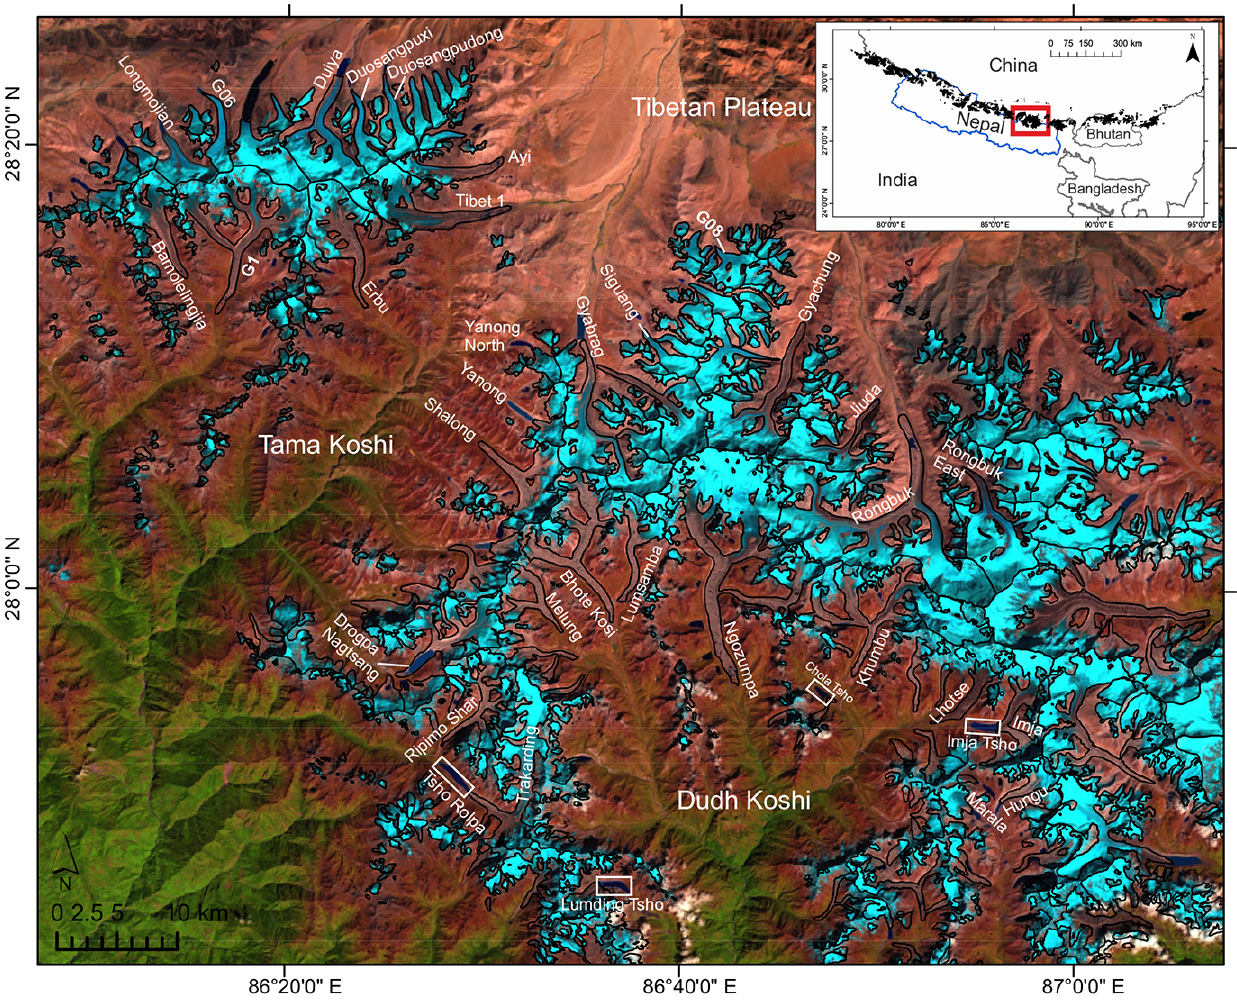
Figure 1. The glaciers of the Everest region. Named glaciers are the glaciers we highlight in this study. Major catchments include the Tama Koshi and Dudh Koshi on the southern flank of the Himalayas and the Pumqu river catchment on the northern side of the divide, with glaciers flowing onto the Tibetan Plateau (China). Named glacial lakes are highlighted, although many remain unnamed. Background imagery is a Landsat OLI image from 2014 available from